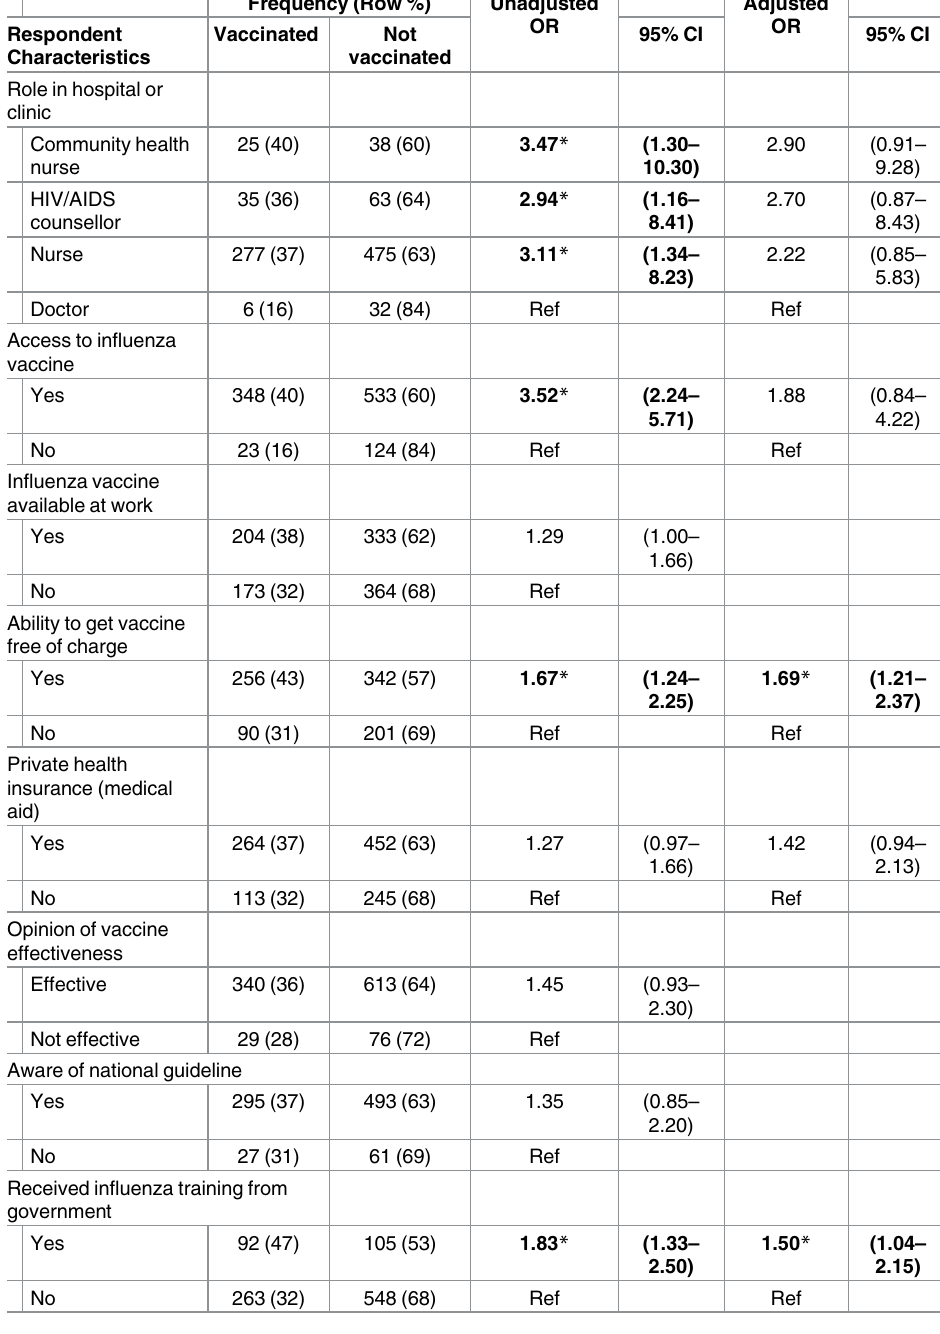
Frequency (Row %) Unadjusted